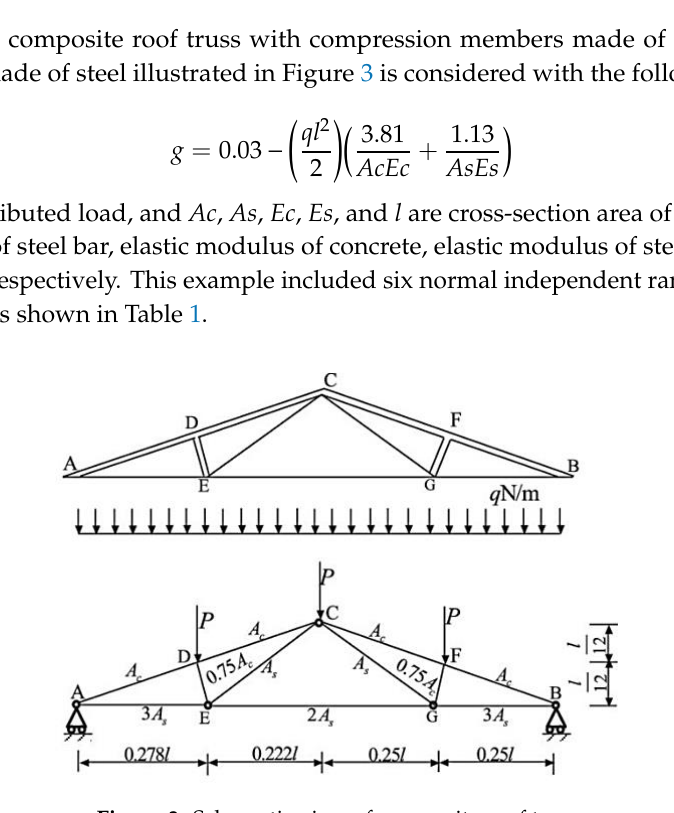
Figure 3. Schematic view of composite roof truss. Table 1. Random variables for roof truss.